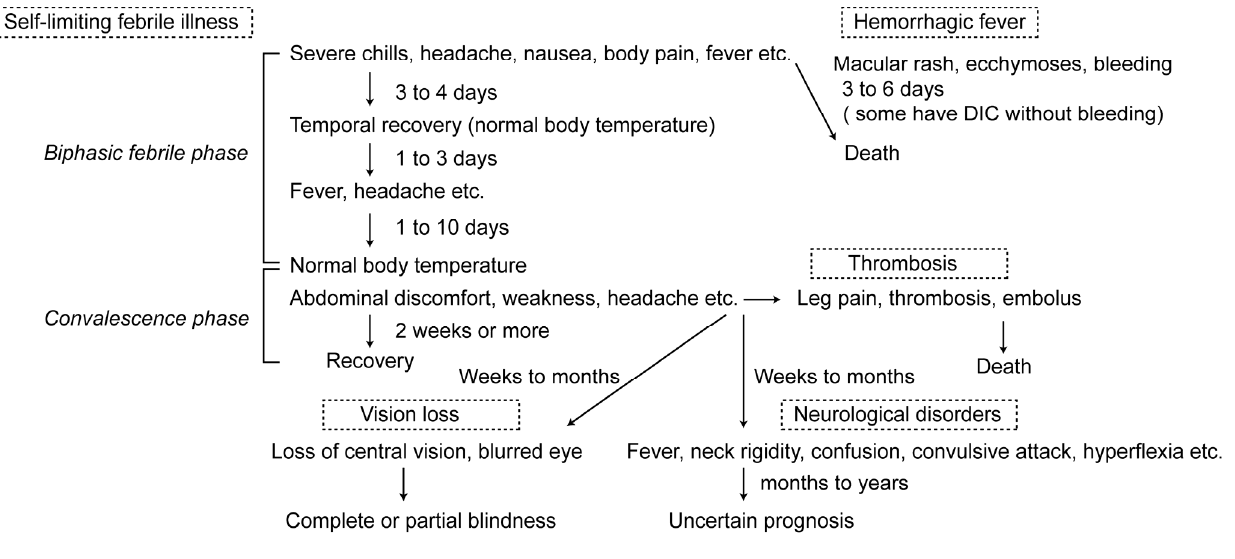
Figure 1. The pathological forms of Rift Valley fever in